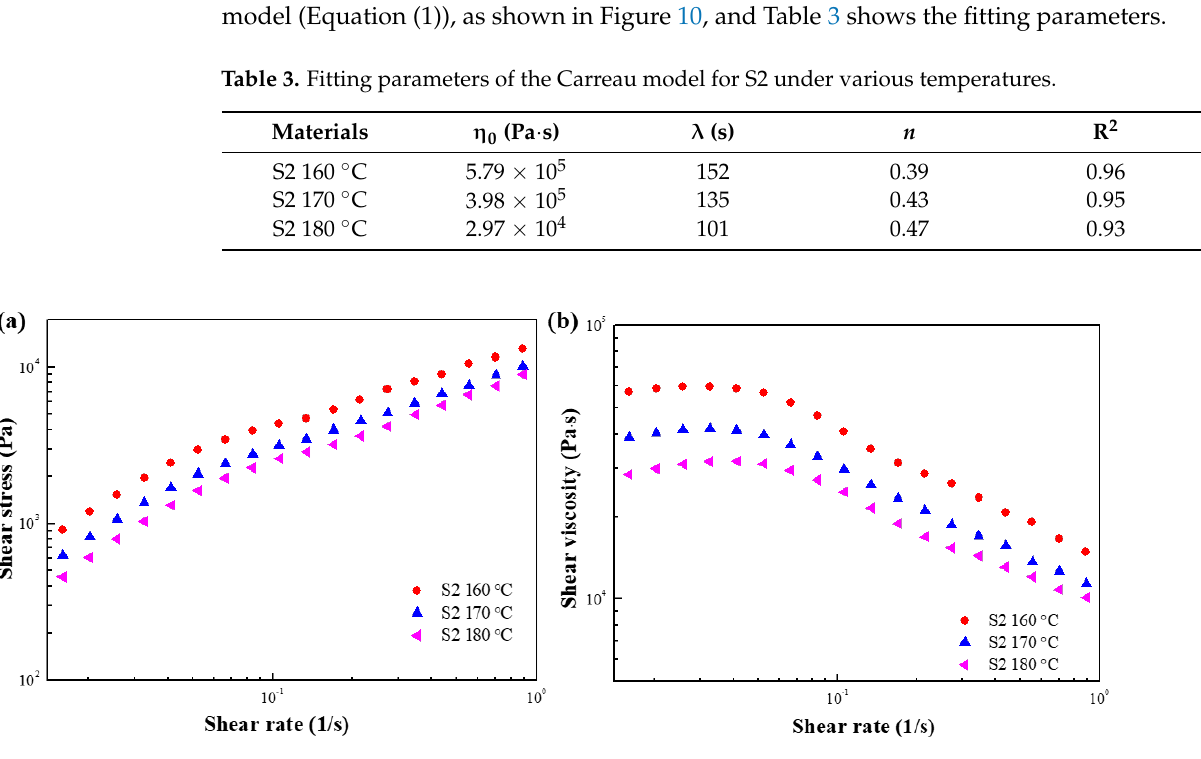
Figure 8. Storage (closed symbols) and loss (open symbols) modulus of ( a ) temperature sweep test and ( b ) strain amplitude sweep test for S2.